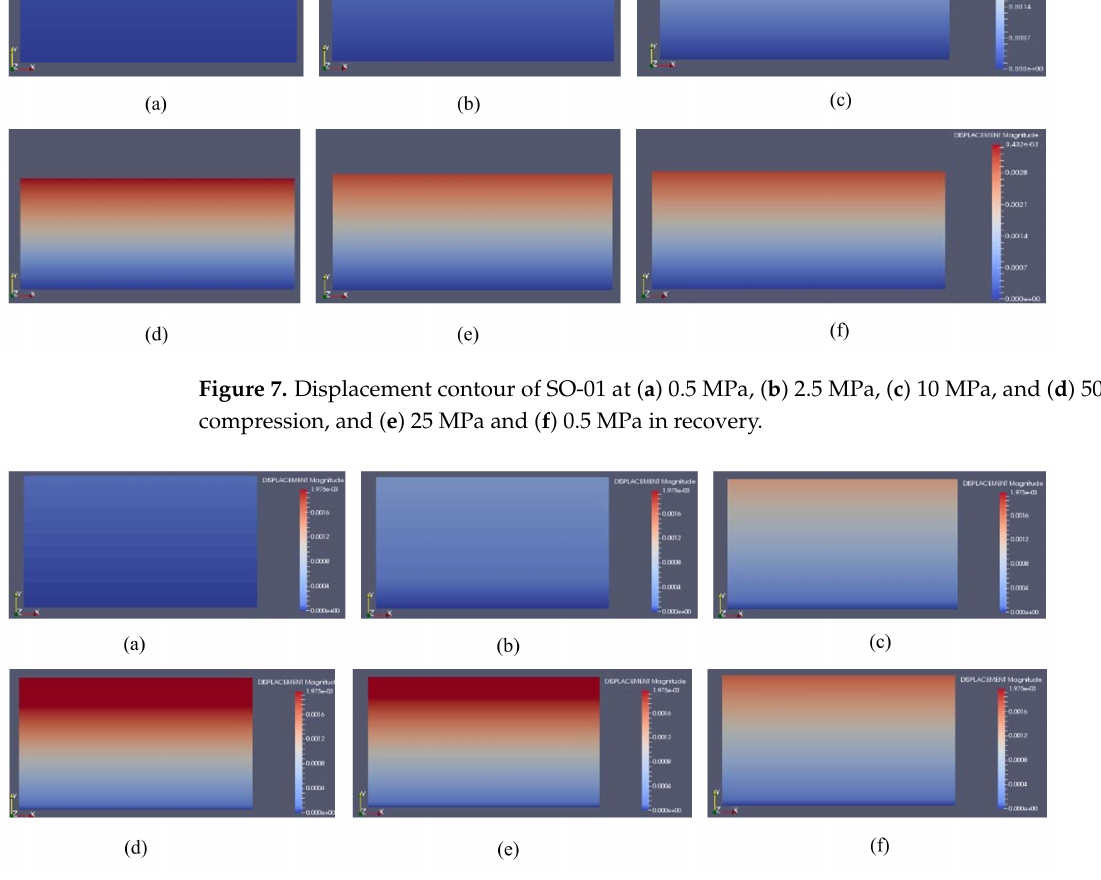
Figure 8. Displacement contour of SO-02 at ( a ) 0.5 MPa, ( b ) 2.5 MPa, ( c ) 10 MPa, and ( d ) 50 MPa in compression, and ( e ) 25 MPa and ( f ) 0.5 MPa in